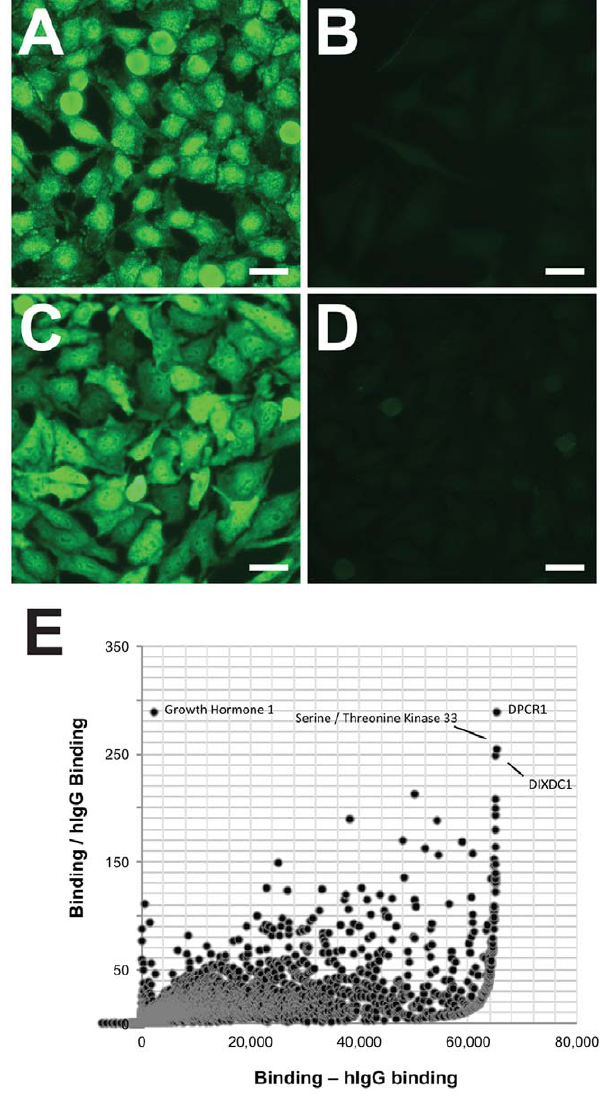
Figure 6. Autoreactivity of mAb CH07. A–D. Indirect immunoflu- orescence staining of HEp-2 cells was strongly positive for mAbs CH07 (A, diffuse nuclear and clumped peripheral staining pattern) and 2F5 (C, diffuse cytoplasmic and nuclear staining pattern); mAbs CH08 (B) and 17b (D) were negative. All images taken for 10 s except CH07 taken for 7 s. Size bars are 25 m m. E. Reactivity of mAb CH07 to 9,000 human proteins in a microarray was assessed, each spot represents binding to a single protein. Pooled human IgG (hIgG) was used to measure background binding. The X-axis represents antibody binding minus background. The Y-axis represents antibody binding divided by the background binding. Positive signals for specific proteins are indicated by